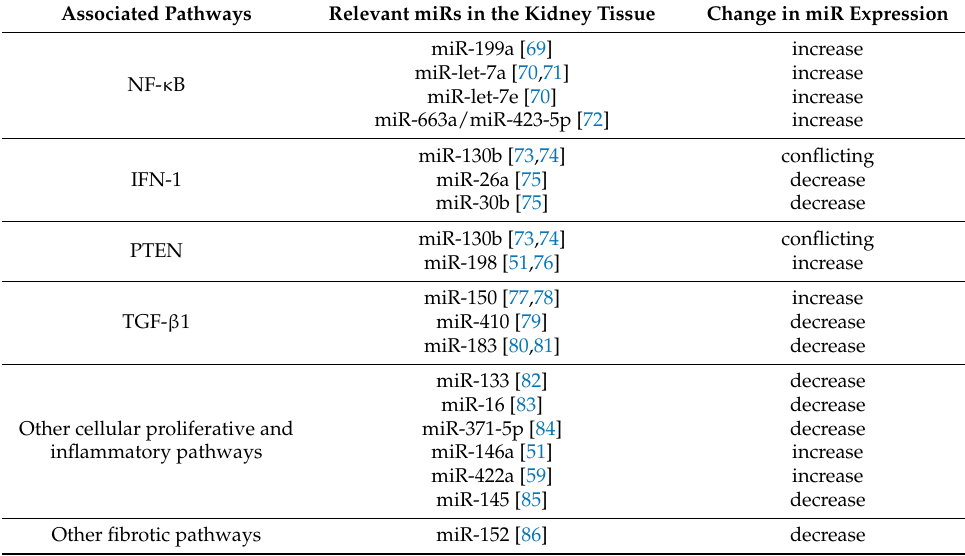
Table 2. Signal transduction pathways involved in the pathogenesis of LN and the expression of relevant miRs in the kidney